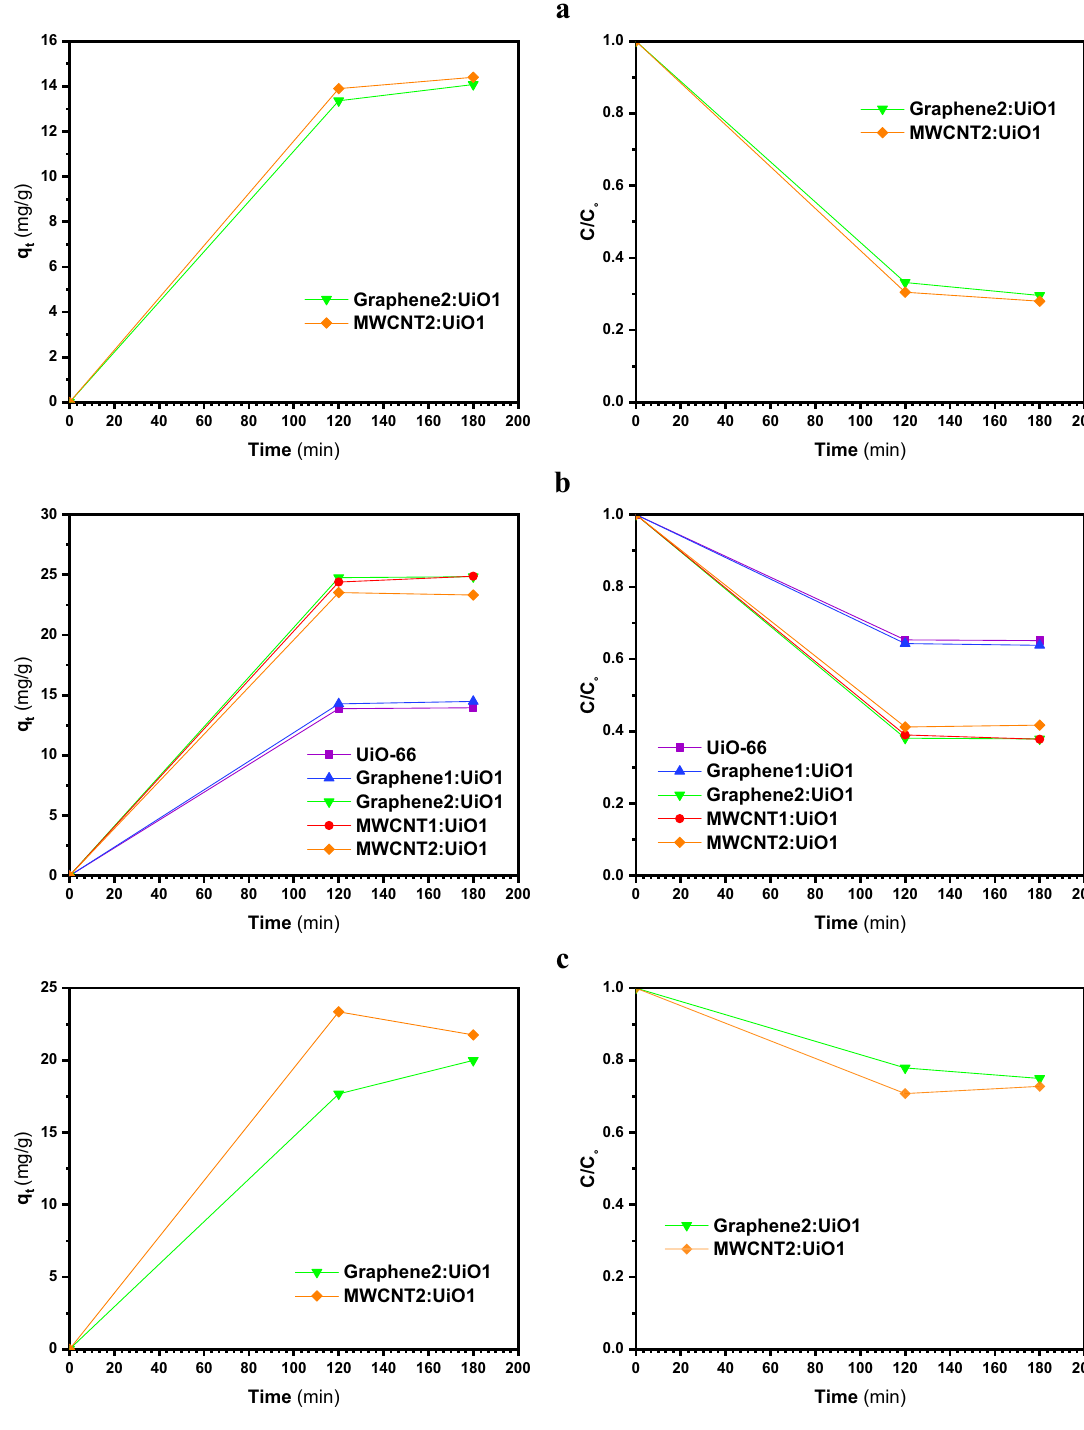
Figure 8. Adsorption capacity and solution concentration in various contact time of MB with initial concentrations of ( a ) 10 ppm, ( b ) 20 ppm, ( c ) 40